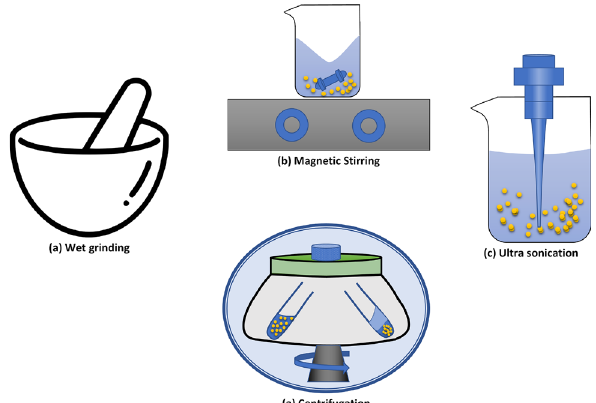
Figure 10. Process of ink preparation.